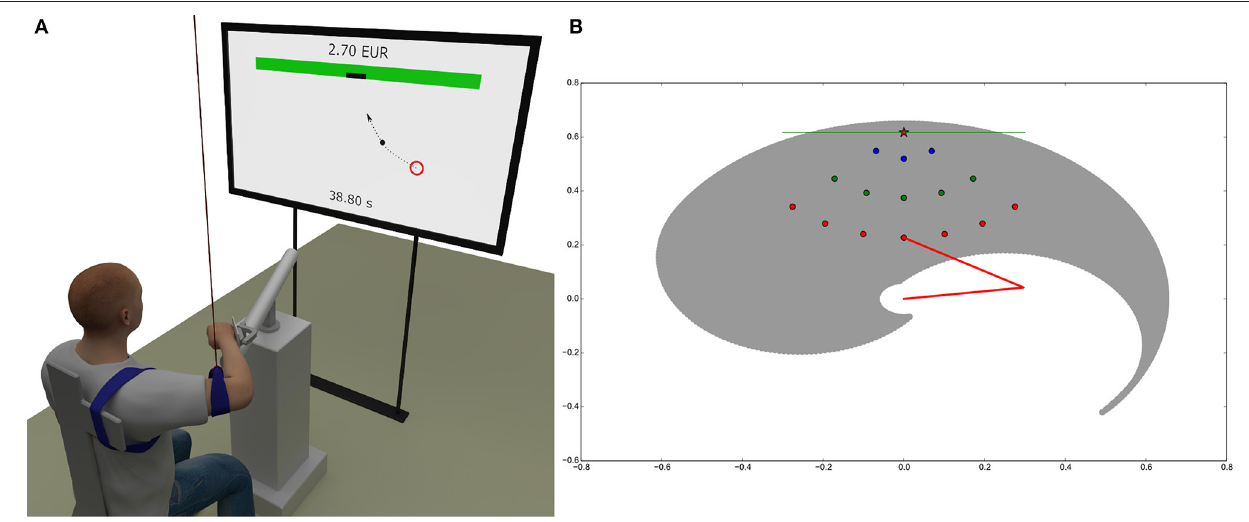
FIGURE 5 | Experimental and simulation setup. (A) Subjects sat on a chair in front of a TV screen with the right wrist connected to the haptic manipulator that constrained the motion of the right hand to the horizontal plane at the shoulder height. The screen displayed the current position of the subject’s hand, the randomly occurring initial circular areas, the target on the virtual wall and gave feedback about the remaining time and the cumulative reward. (B) Simulated arm workspace and distribution of the 15 initial circular areas relative to the target on the wall. The reachable space is delimited by a spiral-shaped envelope (gray). The two segments of the arm are represented by red lines. The screen is represented as a green line positioned at y = 0.6175 m and the target center as a red star. The origin of the arm is at x = 0.0, y = 0.0. Initial areas are organized into three sets at different distances to the target, corresponding to 15% (3 blue circles), 37.5% (5 green circles), and 60% (7 red circles). The color code of the dots depending on the distance to the target is reused throughout the paper (in Fitts’ law and velocity profiles diagrams).